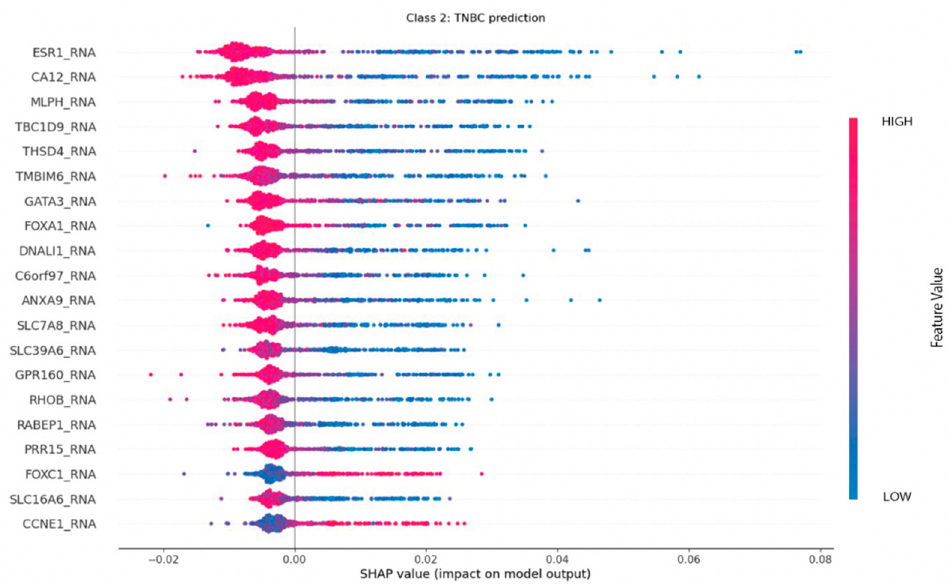
Figure 13. SHAP plot for TNBC prediction.